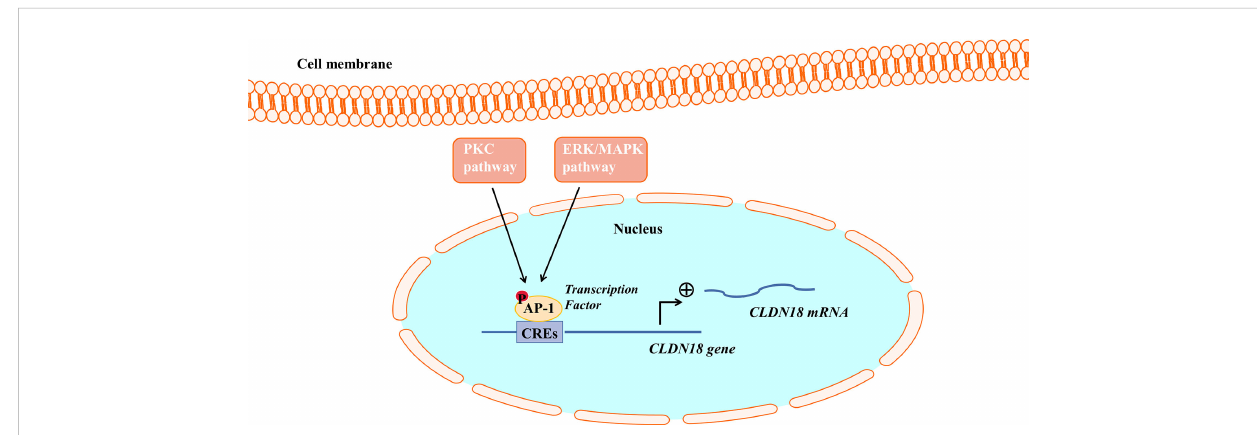
FIGURE 3 The PKC pathway and ERK/MAPK pathway regulate CLDN18.2 expression. AP-1 could bind to cis-regulatory elements (CREs) of the CLDN18.2 promoter, increasing the transcriptional activity of CLDN18.2. The PKC and ERK-MAPK pathways enhance the transcription of CLDN18.2 mRNA by stimulating the phosphorylation and activation of